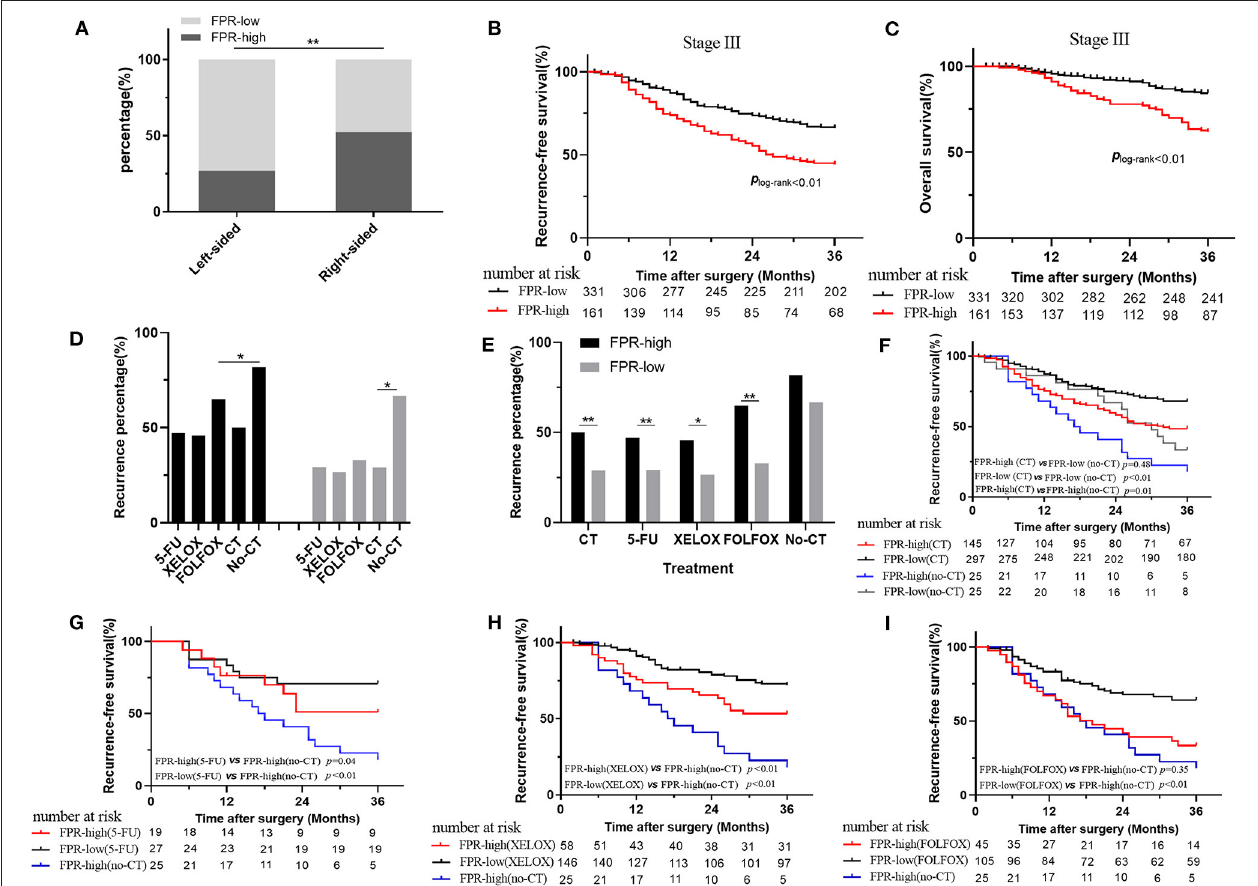
FIGURE 3 | Association of preoperative FPR with clinical outcome in stage III colorectal cancer patients. (A) The distribution of high- and low-FPR in left-sided and right-sided cancer. (B) Kaplan–Meier curves for RFS in the stage III patients with high and low FPR. (C) Kaplan–Meier curves for OS in the stage III patients with high and low FPR. (D,E) The recurrence rate comparison in stage III patients with or without chemotherapy treatment. (F) Kaplan–Meier curves for RFS in high- and low-FPR chemotherapy-treated subgroups and non-chemotherapy-treated subgroup. (G) Kaplan–Meier curves for RFS in non-chemotherapy-treated patients, low- and high-FPR subgroups with the treatment of 5-FU. (H) Kaplan–Meier curves for RFS in non-chemotherapy-treated patients, low- and high-FPR subgroups with the treatment of XELOX. (I) Kaplan–Meier curves for RFS in non-chemotherapy-treated patients, low- and high-FPR subgroups with the treatment of FOLFOX; HR, hazard